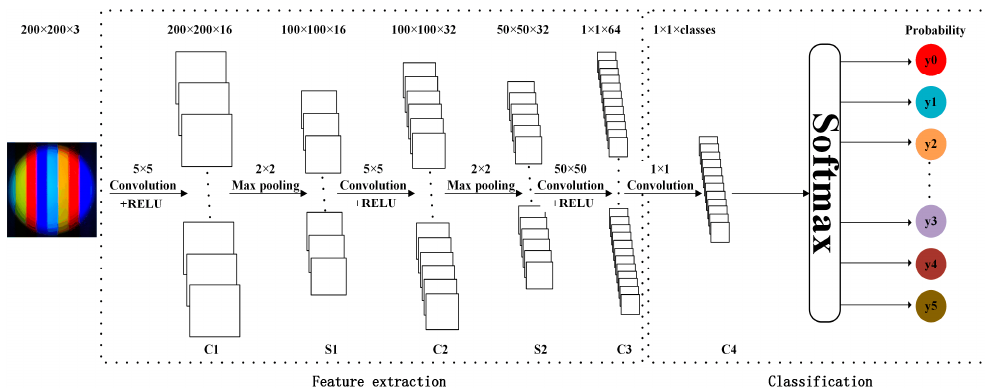
Figure 6. The architecture of the CNN used.